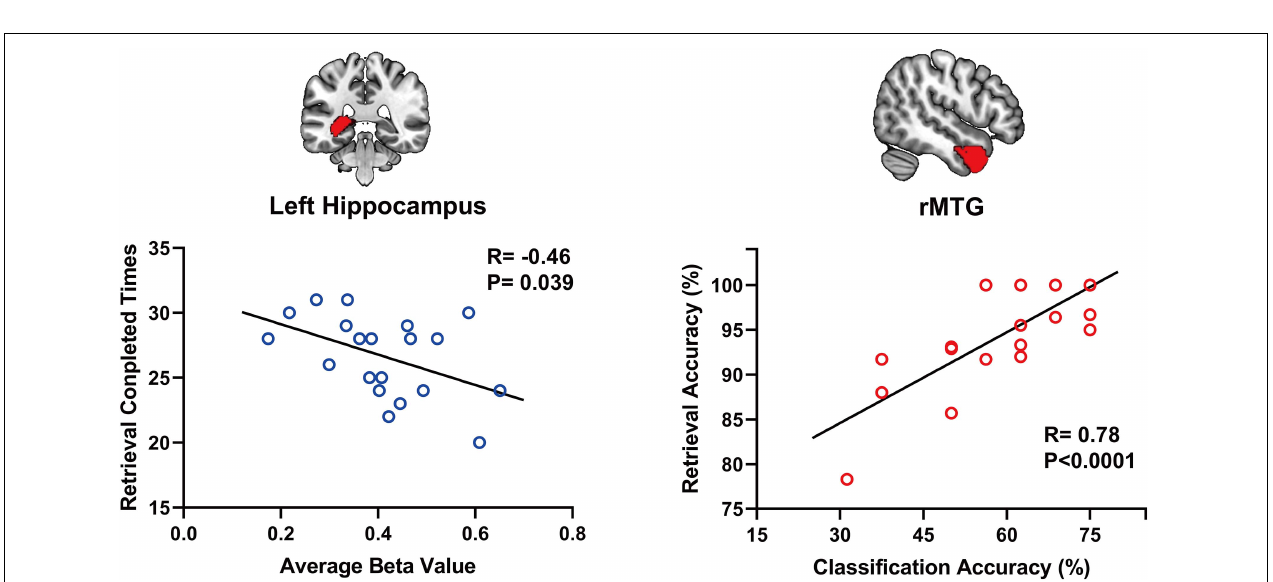
FIGURE 3 | The beta value in the left hippocampus shows a significant negative correlation ( r = 0.46, p = 0.039) with the number of task completions (left) . Within-subject classification accuracies positively correlated with the spatial memory retrieval accuracy ( r = 0.775, p = 0.0079) in the rMTG (right) .